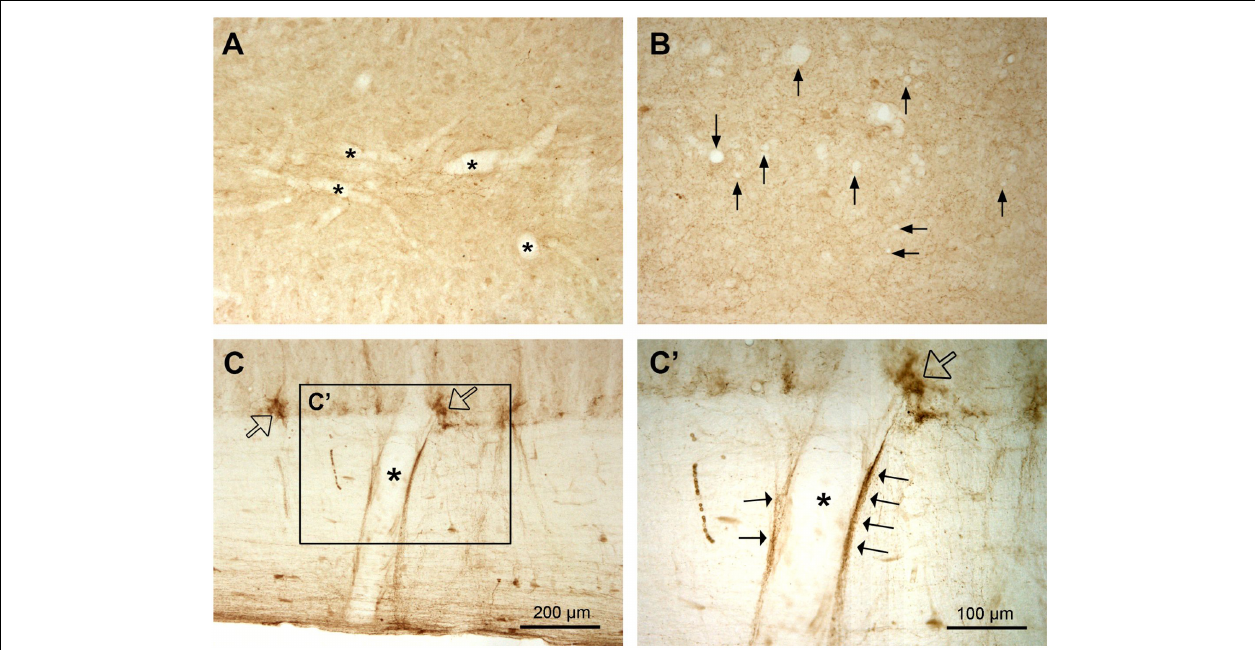
FIGURE 12 | No AADC immunoreactivity in the blood vessels in the spinal cord in normal rats. (A,B) AADC immunoreactivity was detected neither in the larger (stars in A ) nor in the smaller vessels (arrows in B ). The sections were from a L 6 segment. Note that (B) is one-time more amplified than (A) (see the scale bars in C and C’ ). (C) A large vessel (star) in the white matter in a L1 segment seems to be AADC-IR. However, in the enlarged photograph ( C’ , the rectangular area in C ) the IR components (arrows) seem to come from the associated AADC fiber/varicosity clusters in the intermediate lateral nucleus (hollow arrows in C and C’ ). All sections are horizontal sections. (A,B) are from regions above the CC. AADC antibody was from rabbit. Scale bar in (C) , valid for (A,C) , 200 µ m; in (C’) , valid for (B) and (C’) , 100 µ